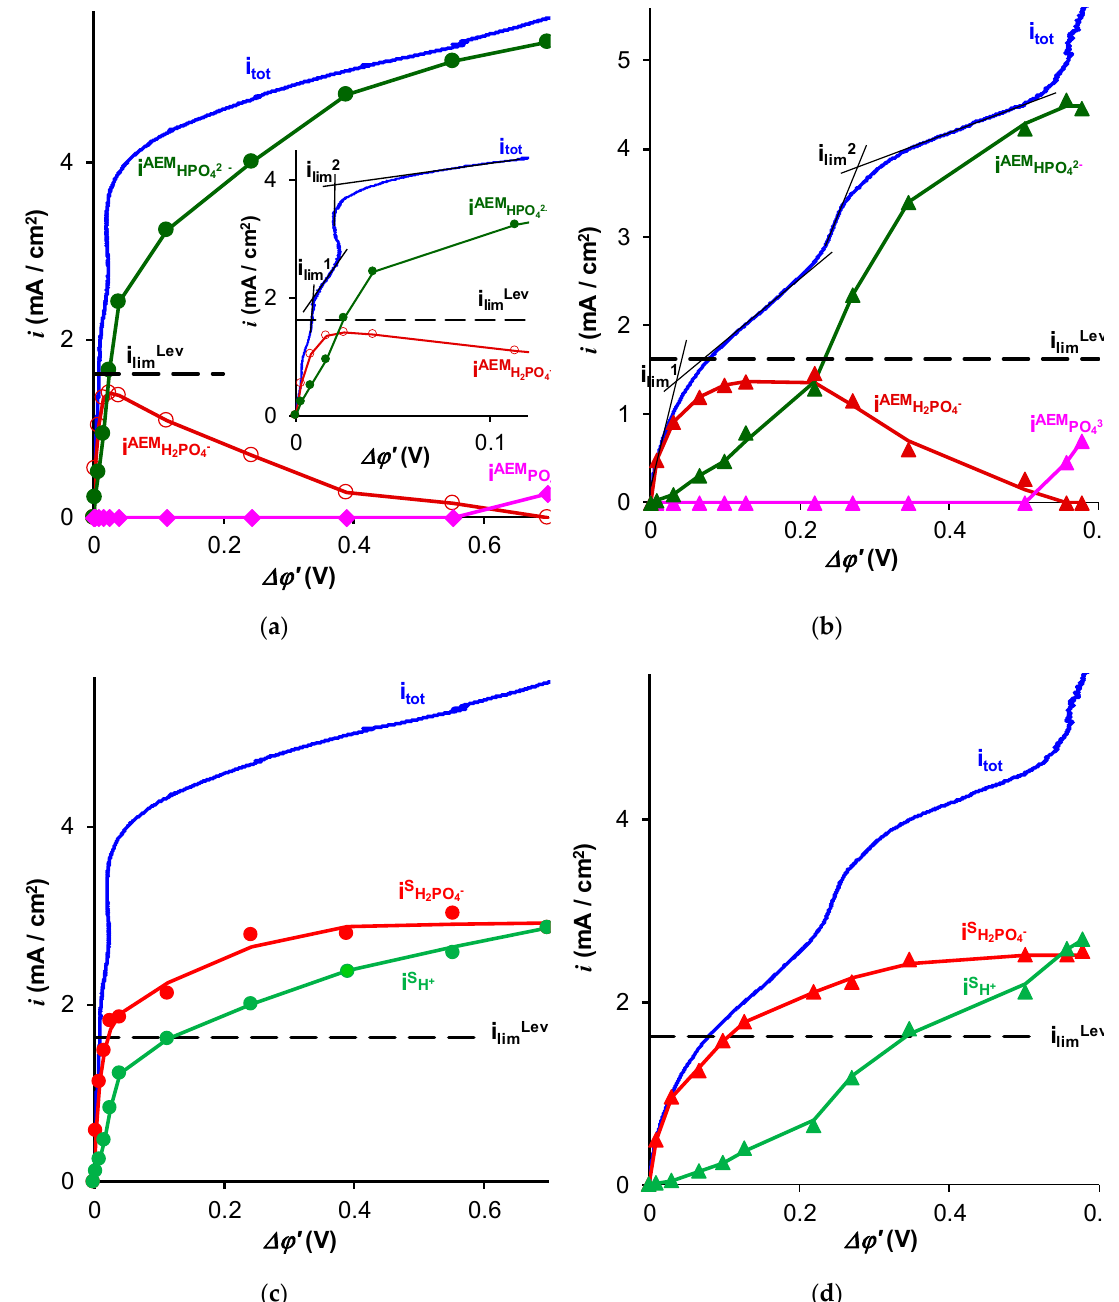
AEM ), HPO 42– i H 2 PO 4 − − ), HPO 42– ( H PO 2 4